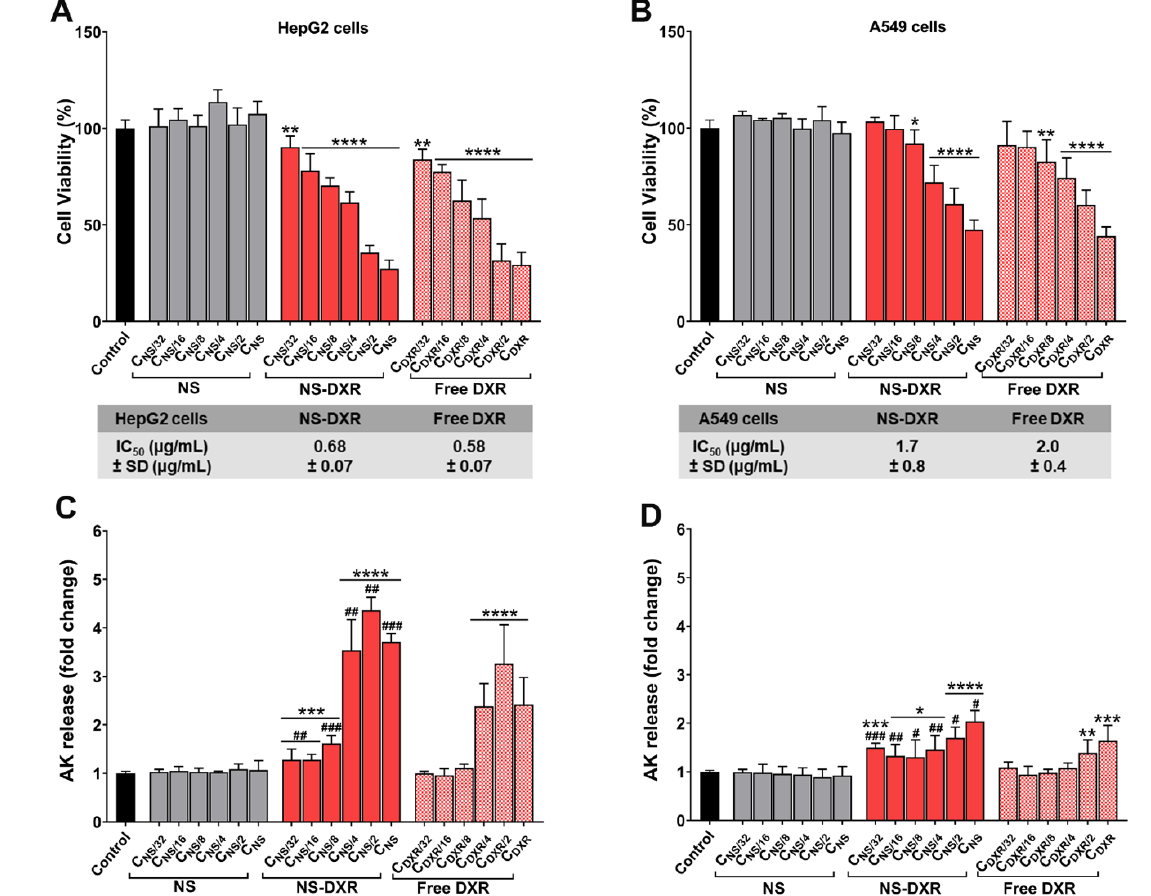
Figure 3. The viability of HepG2 ( A ) and A549 ( B ) cells after exposure to plain NS, NS-DXR, and free DXR determined by XTT assay. The cytotoxicity of plain NS, NS-DXR, and free DXR on HepG2 ( C ) and A549 ( D ) cells determined by ToxiLight TM assay. Cells were exposed for 24 h to various concentrations of NS and NS-DXR (3.9 ÷ 125 µ g/mL, C NS = 125 µ g/mL) and the corresponding concentrations of free DXR (0.078 ÷ 2.5 µ g/mL, C DXR = 2.5 µ g/mL). Results are expressed as means ± standard deviation (S.D.) of three experiments performed at least in triplicates. * p < 0.05, ** p < 0.01, *** p < 0.00, **** p < 0.0001 vs. control; # p < 0.05, ## p < 0.01, ### p < 0.001 vs. free DXR.